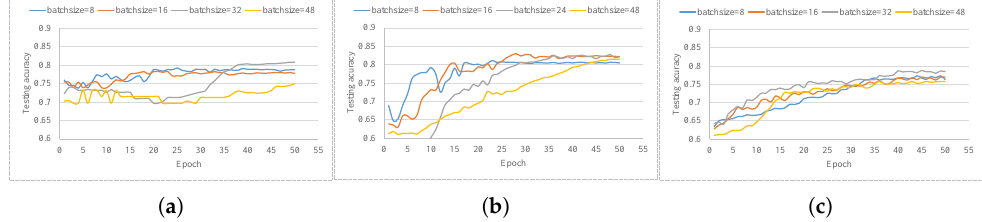
Figure 4. Model accuracy versus training epoch on various batchsize: ( a ) result on MobileNet model; and ( b , c ) result on ShuffleNet and SqueezeNet models, respectively. Blue, orange, gray and yellow curves represent batchsizes equal 8, 16, 32 and 48,